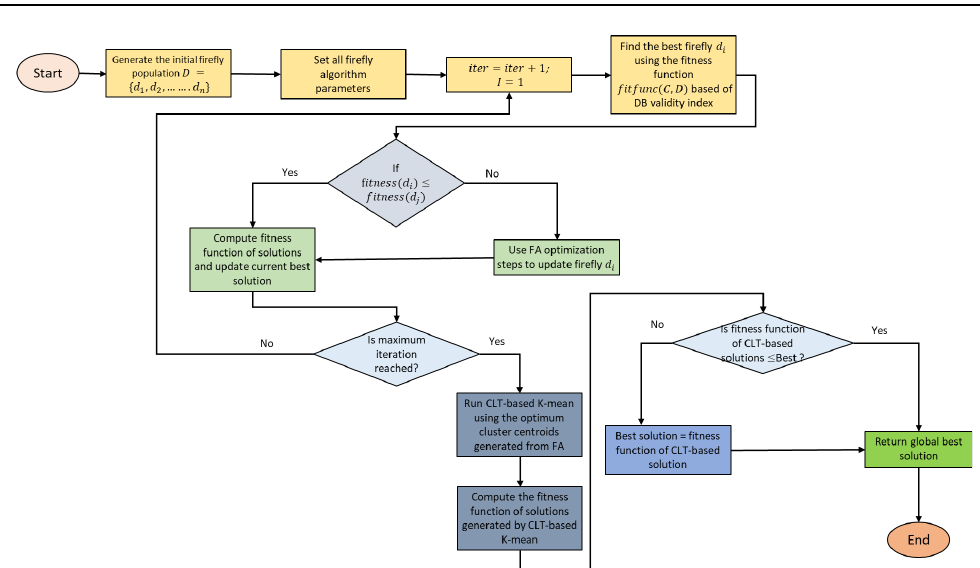
Figure 1. A flowchart for the proposed hybrid firefly algorithm-K-means clustering.